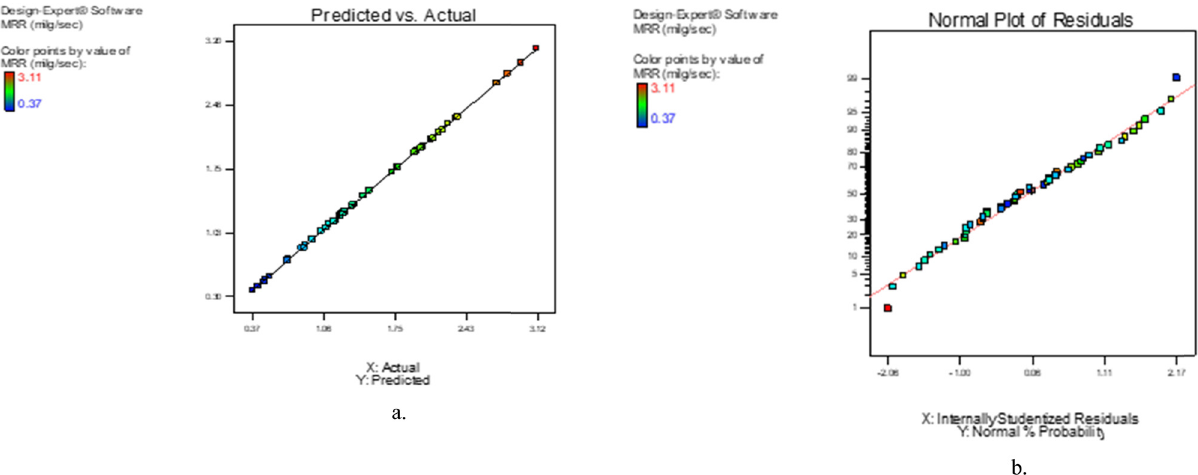
Figure 9: ( a ) Predicted vs actual plot of MRR and ( b ) normal probability plot for